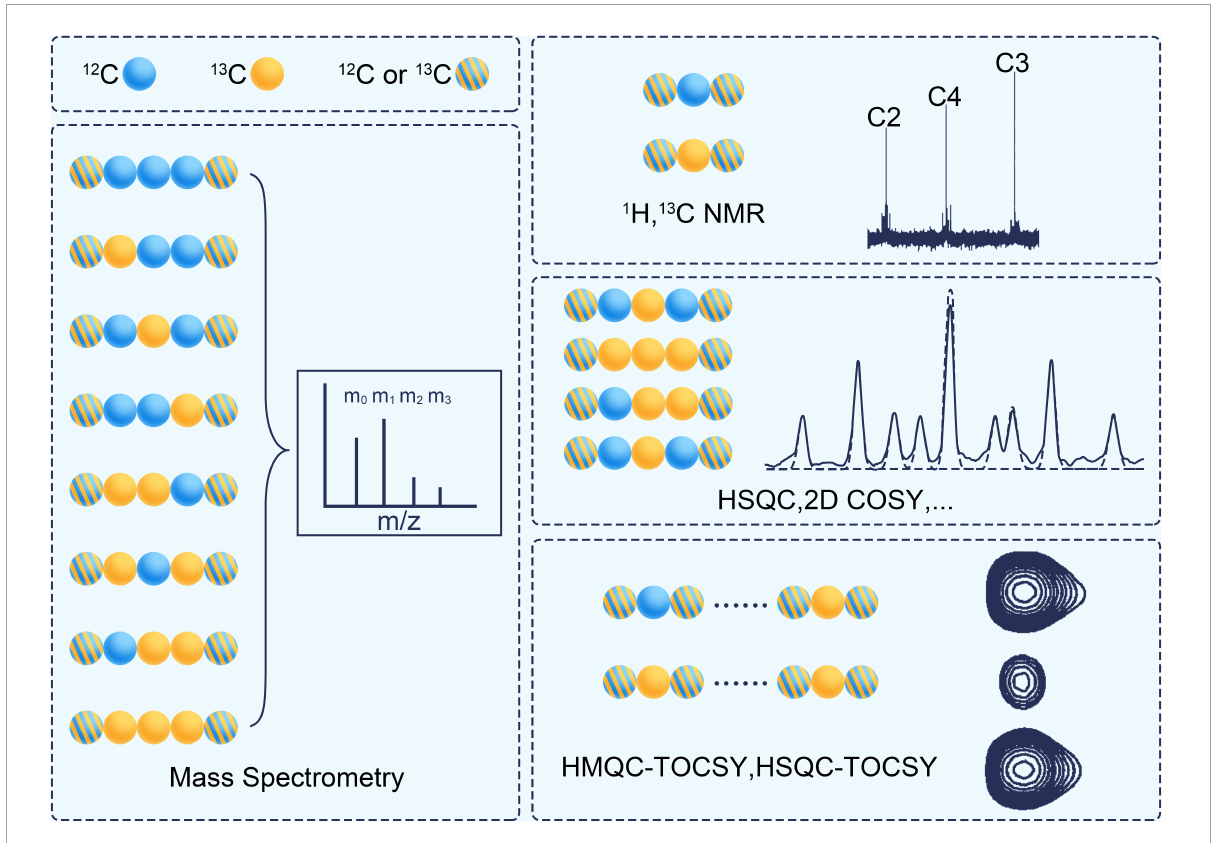
FIGURE5 The analytical techniques for measuring the isotope labeling pattern. Blue ball represents 12 C and yellow ball represents 13 C. The stripped ball represents 12 C or 13 C. COSY, correlation spectroscopy; HSQC, heteronuclear single quantum coherence; HMQC, heteronuclear multiple quantum coherence; TCOSY, total correlation spectroscopy.